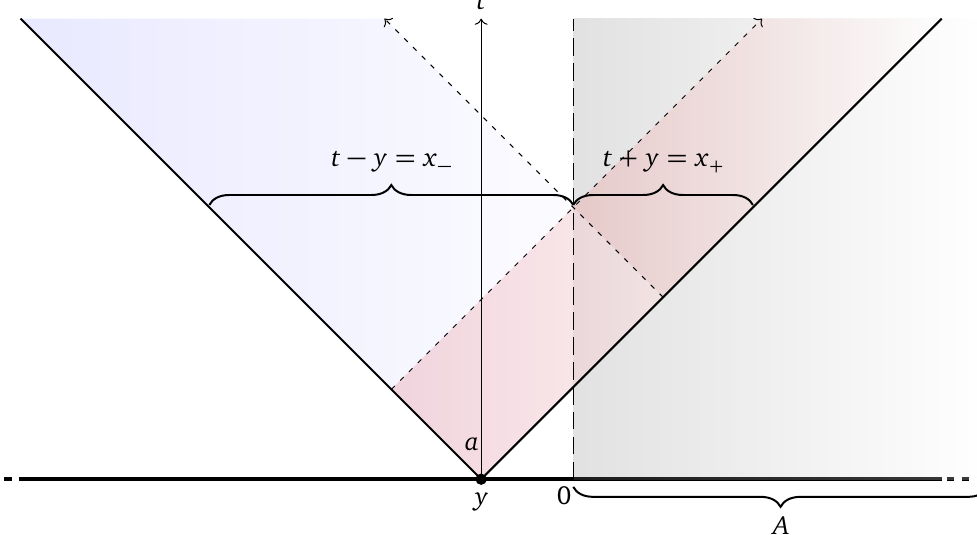
Figure 1: Pictorial illustration of the operatorial evolution, depicting the two limits (72) and (75). The two limits are taken along the dashed arrows. The first limit x − → ∞ has x + constant, which means that as time increases we move the operator to the left getting contribution from the red region. The second limit x + → ∞ has x − constant, meaning that, as time increase we move the operator to the right and get contribution from the blue